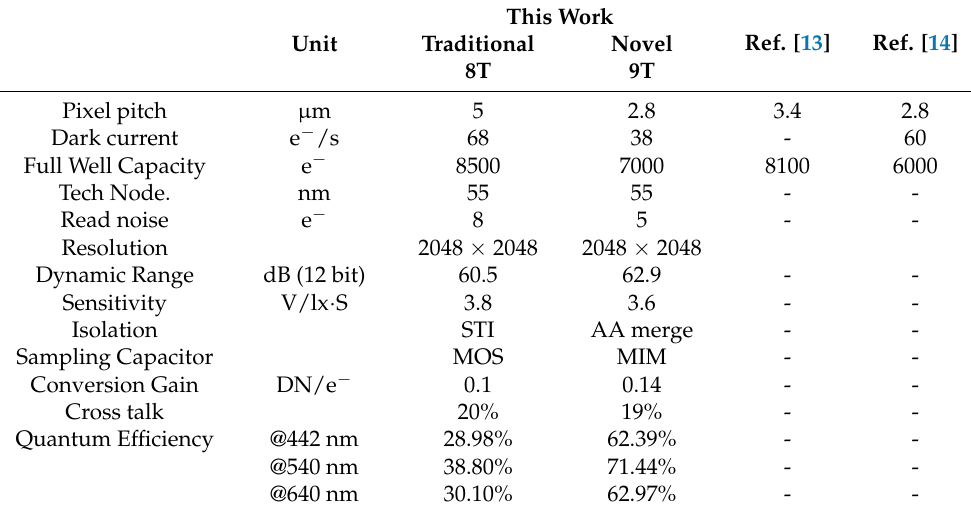
Table 1. Summary of characteristics and comparison with previous reports.